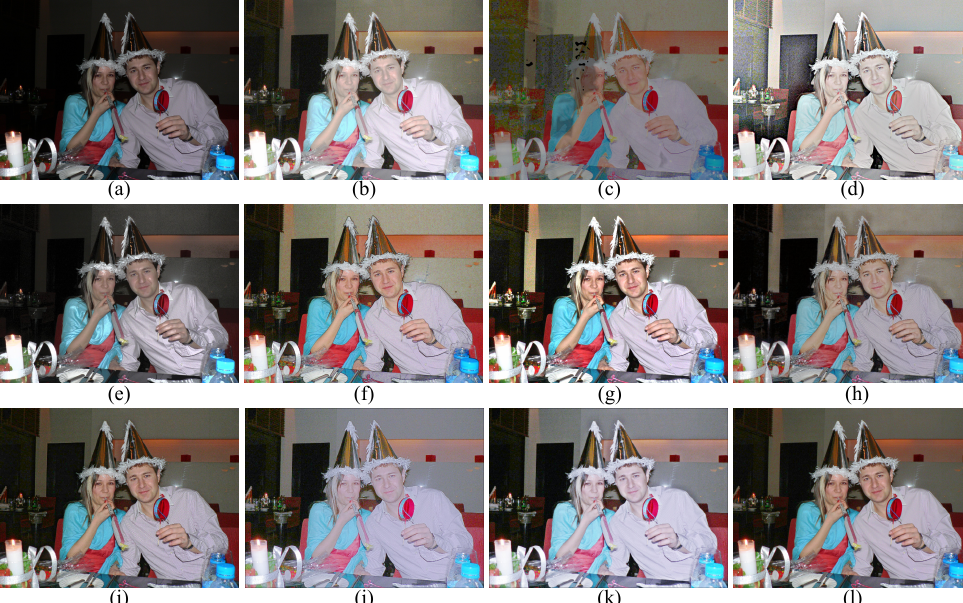
Figure 5. Visual comparison between low-light image enhancement results in the exemplar image.